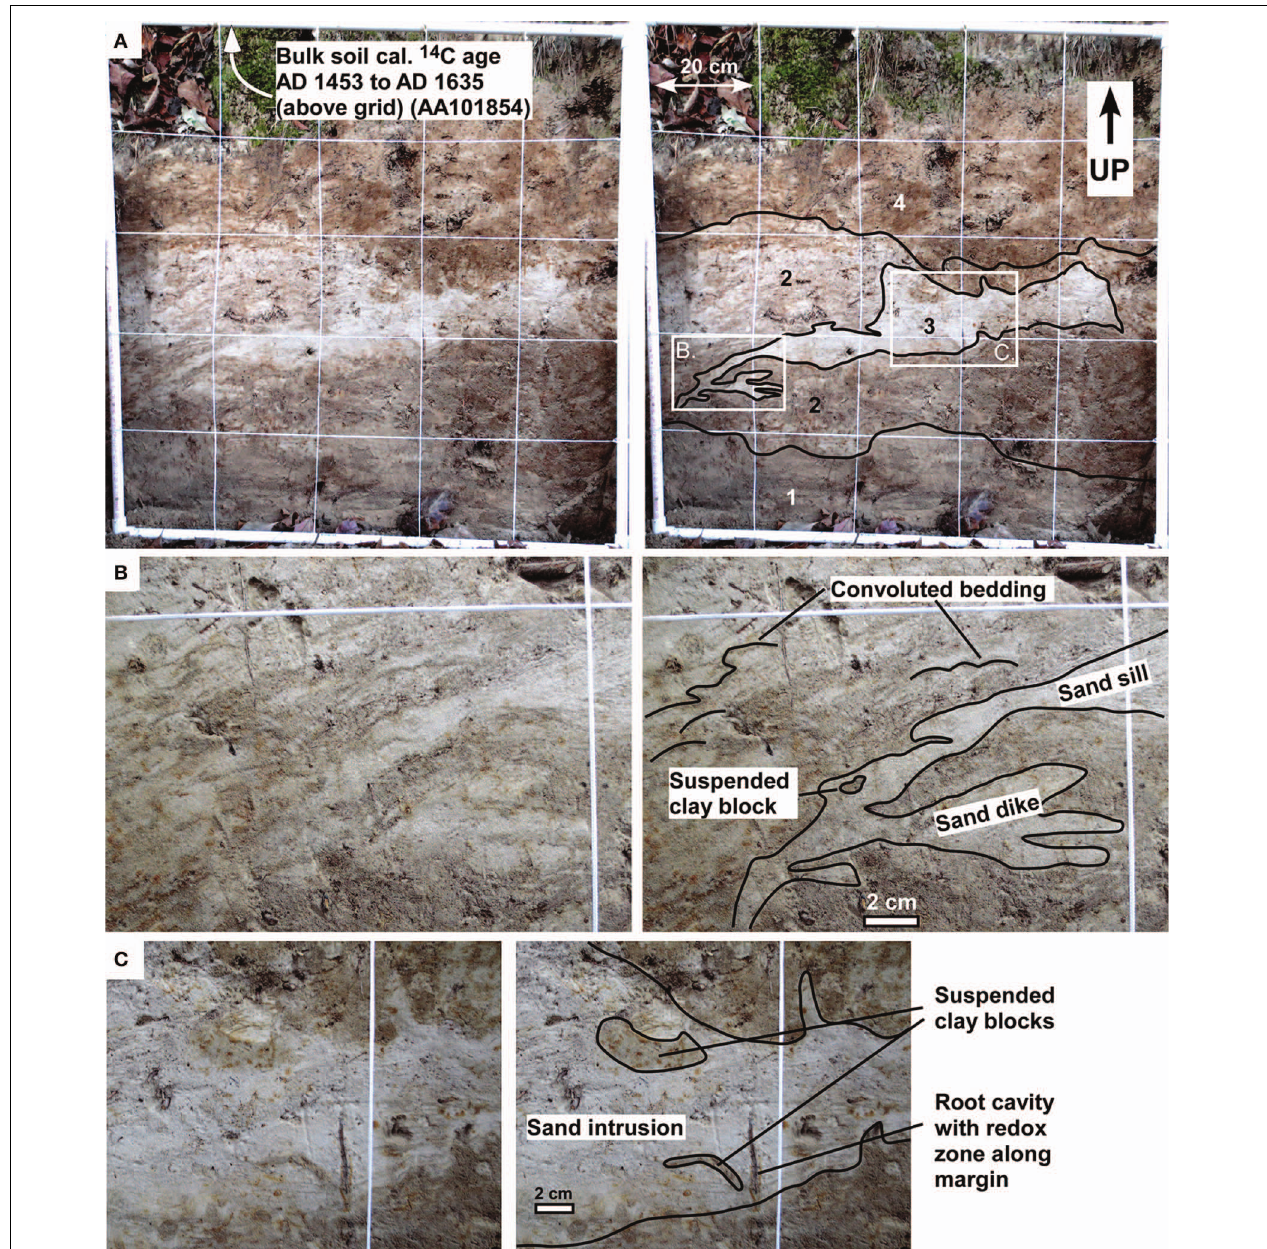
FIGURE 3 | Site A (Upper Cutoff Creek; 33.72764 ◦ N, 91.68954 ◦ W)—Top is up. Locations of (3B,C) are shown on (3A) . (A) Uninterpreted photograph (left) and interpreted photograph (right) of 1 × 1 m grid on vertical excavation showing small-scale bedding irregularities interpreted to be caused by liquefaction during ground shaking. Unit 1, Upper Cutoff Creek channel, massive fine to medium sand; Unit 2, Convoluted Upper Cutoff Creek point-bar, 0.5–1.0cm interbeds of sandy clay and fine to medium sand; Unit 3, Structureless intrusion of fine sand with sharp